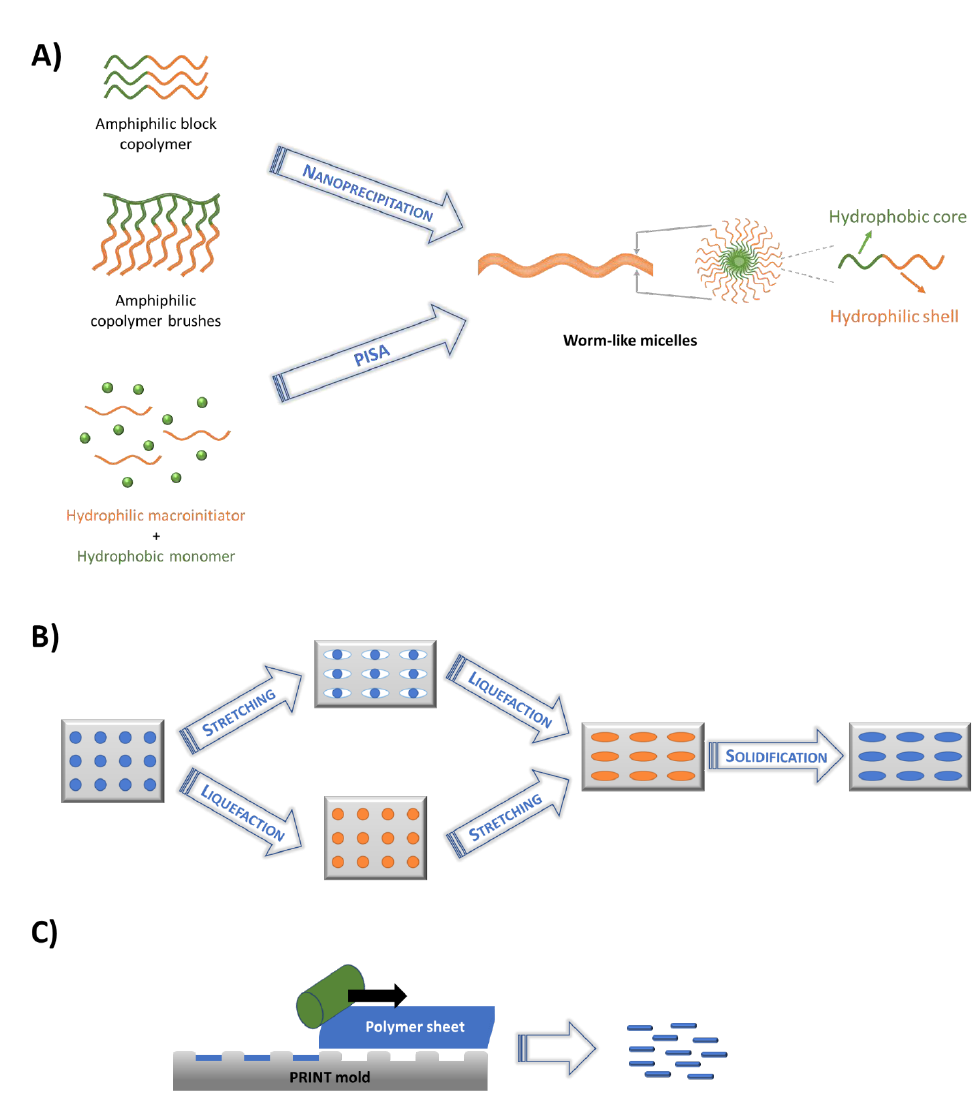
Figure 2. Presentation of the main processes to manufacture non-spherical nanocarriers: ( A ) Self- assembly techniques (orange: hydrophilic group, green: hydrophobic group), ( B ) Membrane stretching method. The film containing the initial nanoparticles is stretched before or after the liquefaction step, which is obtained either by particle solubilization in adequate solvent or by heating above the glass transition temperature, ( C ) Particle replication in nonwetting template (PRINT). This soft lithography technique utilizes highly fluorinated nonwetting molding template to create nano-scale